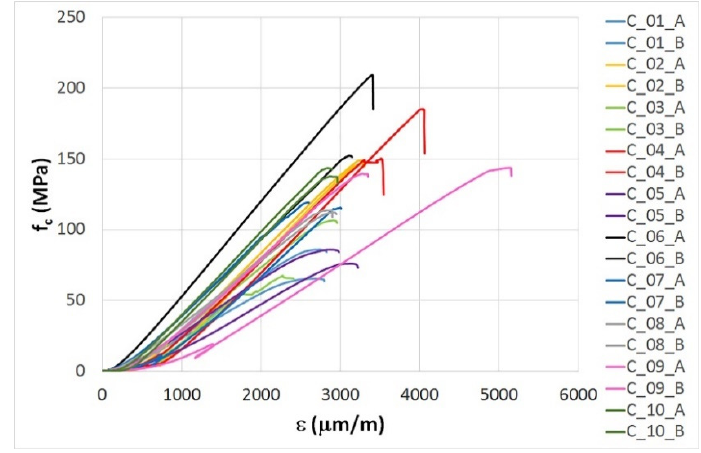
Figure 7. f c - ε diagrams of compression tests.